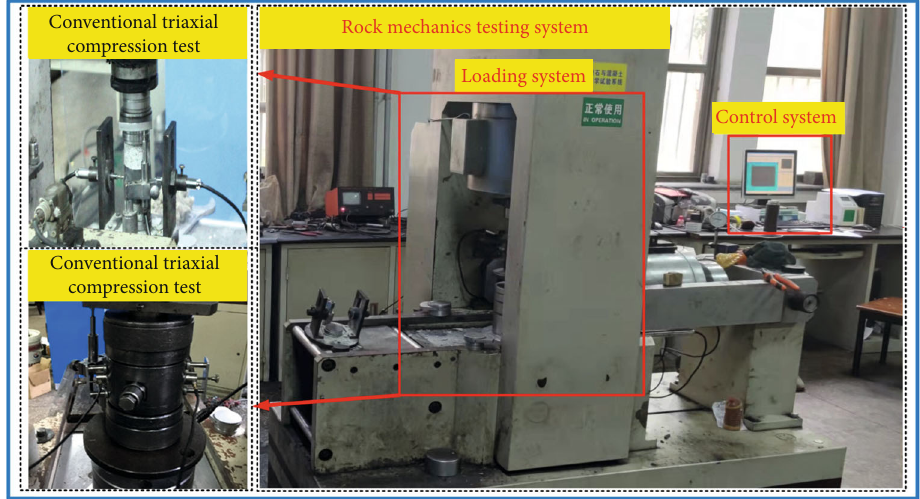
Figure 2: RMT-150 rock mechanics test system and test